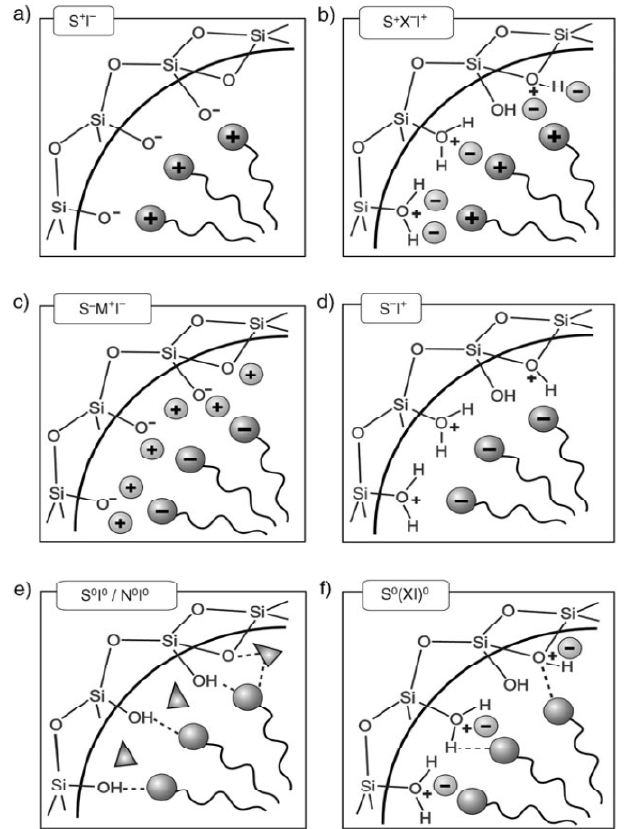
Figure 3. Different kinds of interactions between inorganic species and surfactant head groups through electrostatic interactions in ( a ) and ( c ) basic, ( b ) acidic and ( d ) neutral media or via hydrogen bonds between ( e ) unchared species or ( f ) ion pairs. Reproduced with permission from [93]. Copyright 2006 WILEY-VCH Verlag